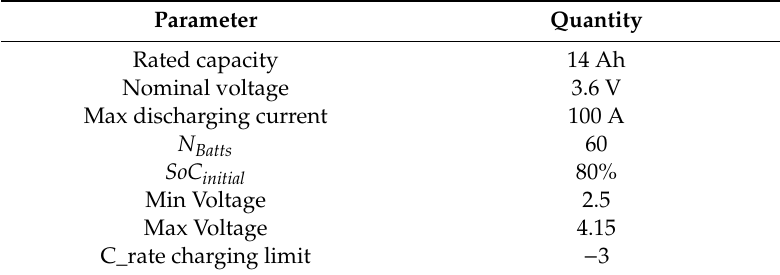
Table 2. LiFePO 4 battery cell specifications.